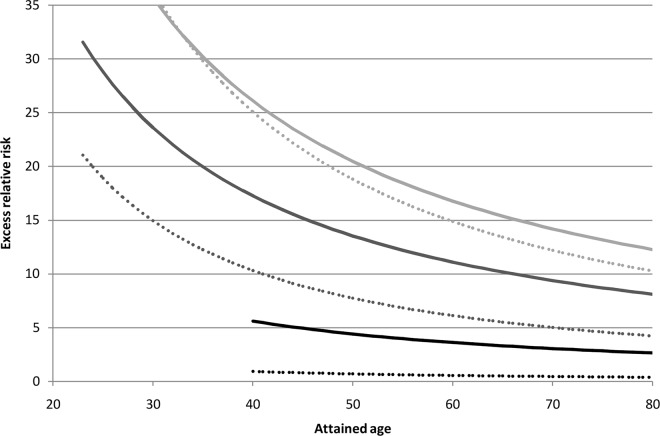
Excess relative risk of leukemia excluding CLL due to accumulated external gamma-dose of 1 Gy in relation to time since exposure and attained age.Solid lines: LSS cohort (excess risk parameters estimates from Table 4 of [3]); dotted lines: Mayak workers cohort; light grey: 3 years since exposure; dark grey: 5 years since exposure; black lines: 20 years since exposure.